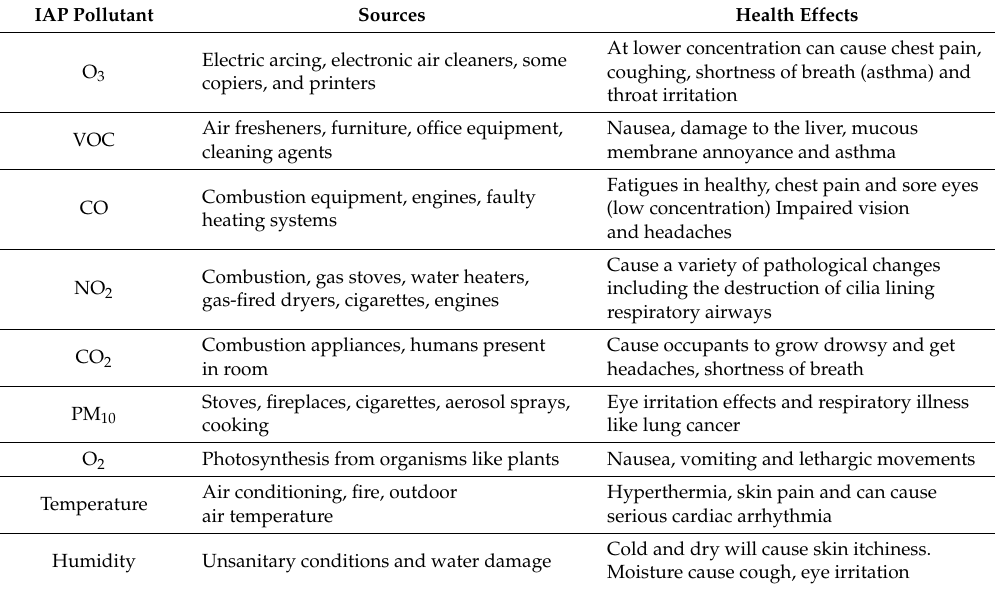
Table 3. Indoor air pollution (IAP) parameters, its sources and health effects to humans.